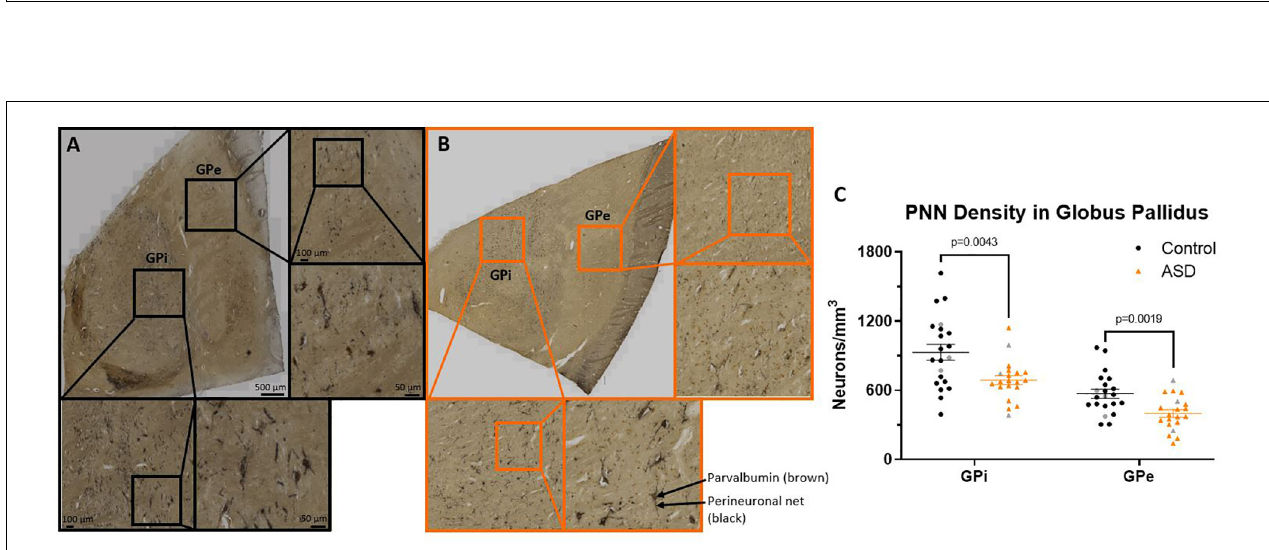
FIGURE 2 | Immunohistochemistry of HPLN1 (black) and parvalbumin (brown) to visualize inhibitory projection neurons surrounded by a perineuronal in a control (A) and ASD (B) case of the globus pallidus (GP). The entire visible region of the GPi and GPe were each included in the contour manually drawn for inclusion within the counting grid. (C) The density of parvalbumin positive neurons surrounded by a perineuronal net were significantly decreased in ASD cases compared to controls in both the GPi and GPe using a Student’s t -test. Females in each group are identified as gray colored symbols.